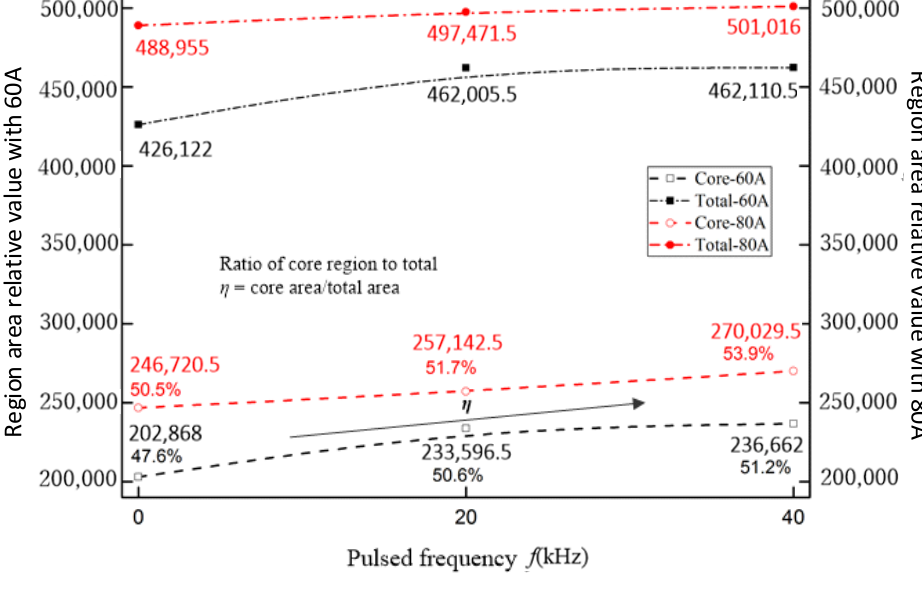
Figure 5. Core region and the total area.